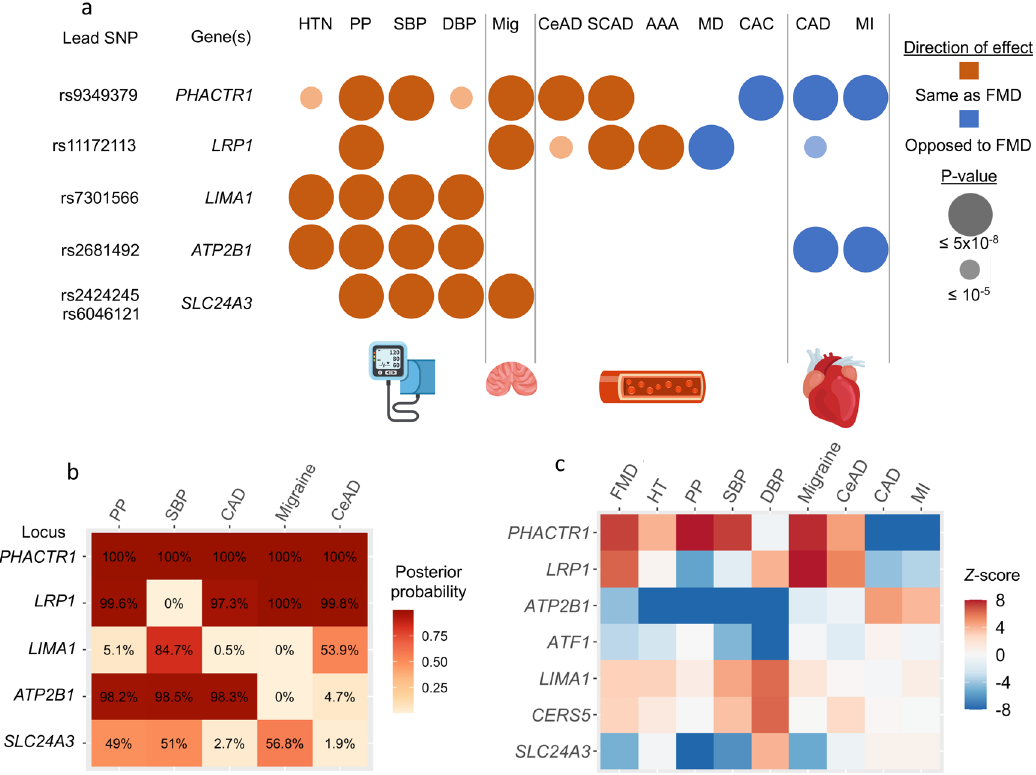
Fig. 4 Pairwise trait colocalization of FMD associations. a Associations of FMD loci with other vascular diseases. Variants in LD ( r 2 > 0.5) with the lead SNP were used to query GWAS catalogue database (accessed on August 5th 2020), UK BioBank GWAS traits and speci fi c meta-analysis of GWAS for CAD/MI, stroke, blood pressure and intracranial aneurysms. Two independent lead SNPs were retained for SLC24A3 locus. Overlaps are reported for the following traits/diseases: hypertension (HTN), pulse pressure (PP), systolic blood pressure (SBP), diastolic blood pressure (DBP), migraine (Mig), cervical artery dissection (CeAD), spontaneous coronary artery dissection (SCAD), abdominal aortic aneurysm (AAA), MoyaMoya disease (MD), coronary artery calci fi cation (CAC), coronary artery disease (CAD) and myocardial infarction (MI). Large bubbles indicate association below genome-wide signi fi cance for the corresponding trait ( P value of genetic association < 5 × 10 − 8 ), smaller bubbles correspond to suggestive signals ( P < 1 × 10 − 5 ). Red colour indicates same direction effects of risk alleles compared to the association with FMD, blue colour opposite direction associations. b Heatmap representation of the approximate Bayes factor posterior probability of FMD and related traits to share a common causal variant at the indicated loci (coef fi cient H4 of the colocalization analysis, represented on a white-red colour scale). c Heatmap representation of TWAS Z -Score for FMD-associated genes. TWAS was performed with tibial artery gene expression models for the indicated traits or diseases ( x -axis). Z -scores, represented on a blue-red colour scale, are shown for all FMD-associated genes in the gene-based and TWAS analyses ( y -axis). Illustrations were designed by